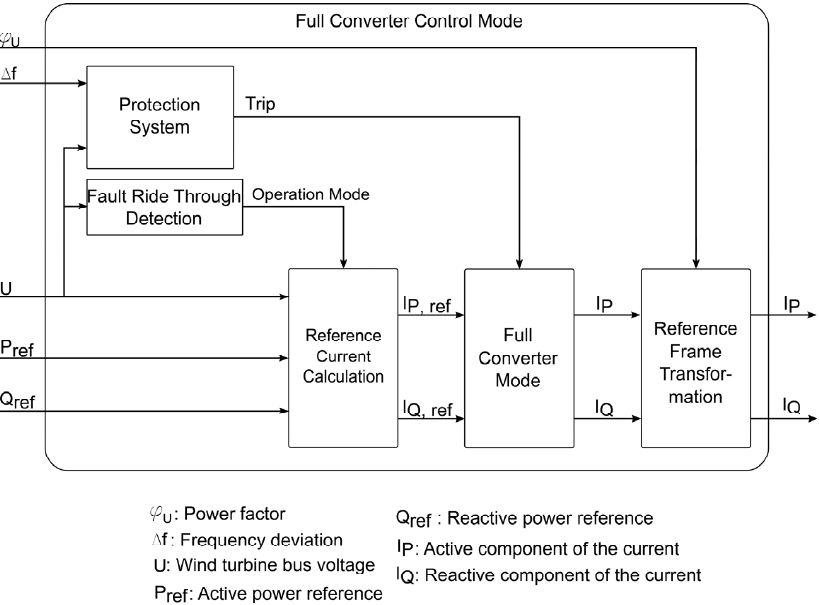
Figure 4. Simplified diagram of the full converter wind turbine model.